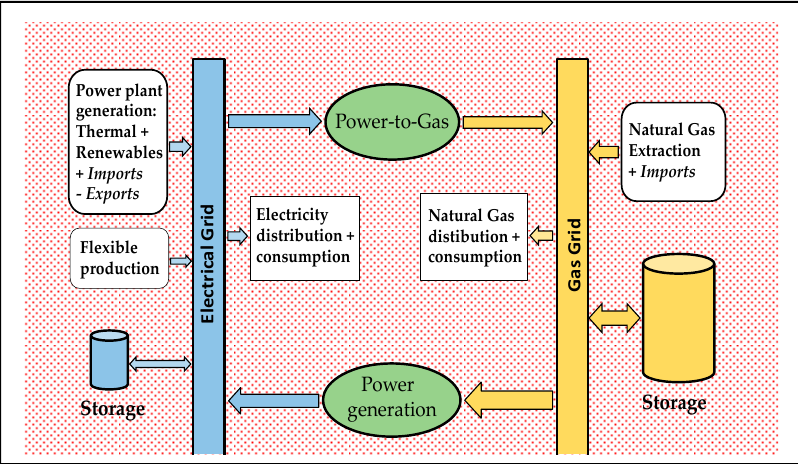
Figure 2. Graphic representation of the Power-to-Gas scheme, integrating the electrical and gas grids with reversing conversions, providing existing services and incorporating both storage capacities.